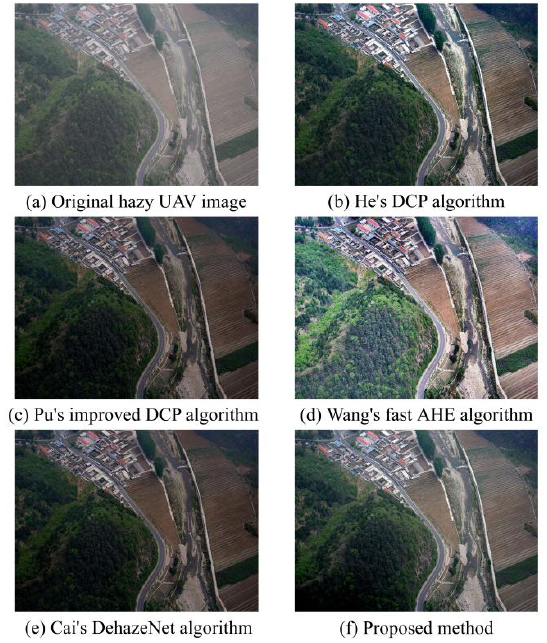
Figure6. Comparison of different methods on images of mountains: (a) Original hazy UAV image. (b) He's Dark Channel prior algorithm. (c) Pu's Improved DCP algorithm. (d) Wang's fast adaptive histogram equalization algorithm. (e) Cai's DehazeNet algorithm. (f) Proposed